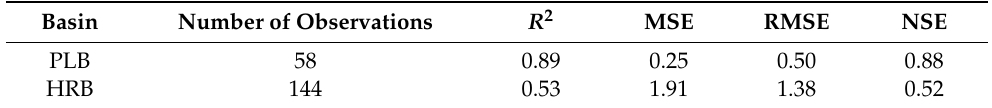
Table 1. Results of SPARROW models.